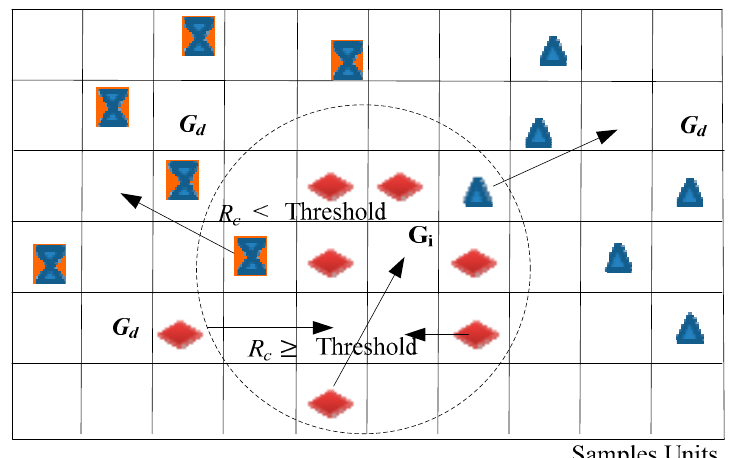
Figure 3. Evaluation of similarities of output datasets by ICC.